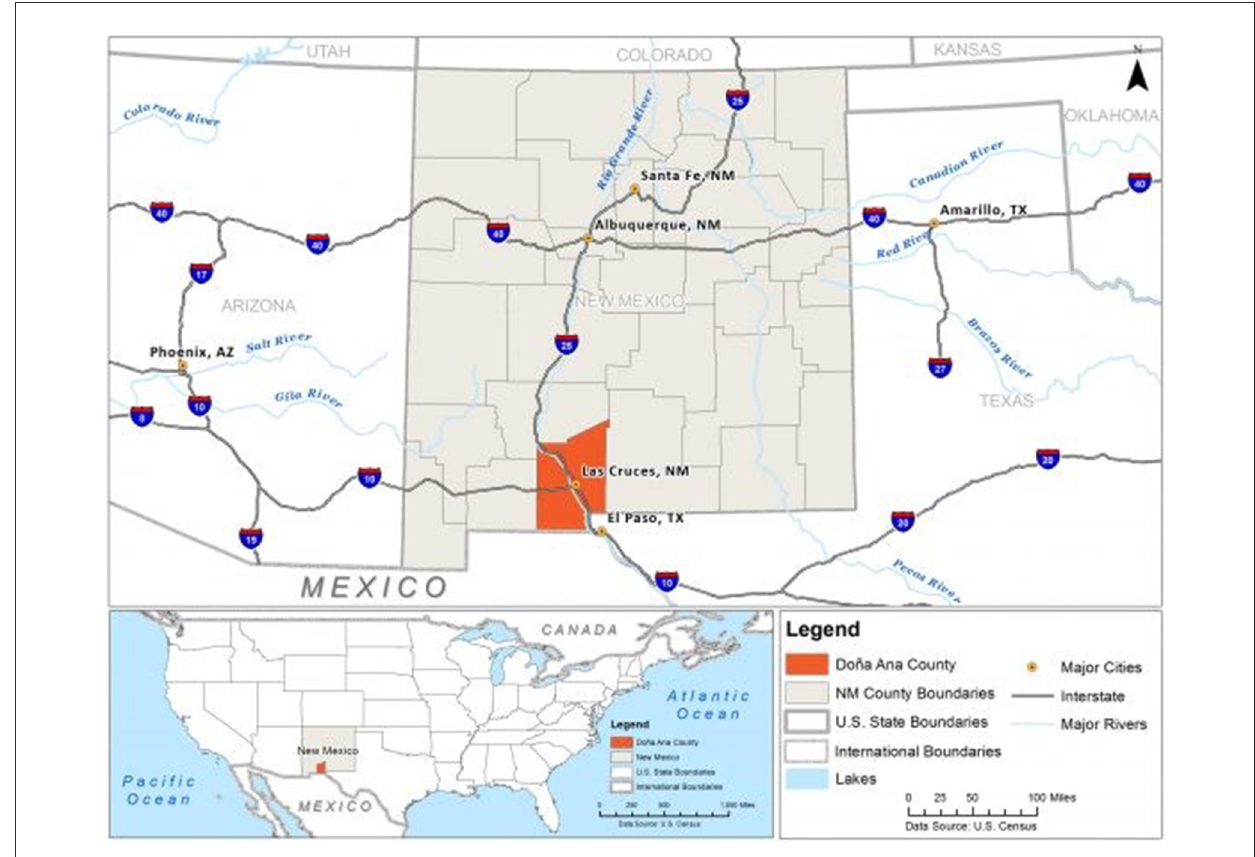
FIGURE1 Map of Doña Ana County, New Mexico. Image Source: Subhashni and Raja